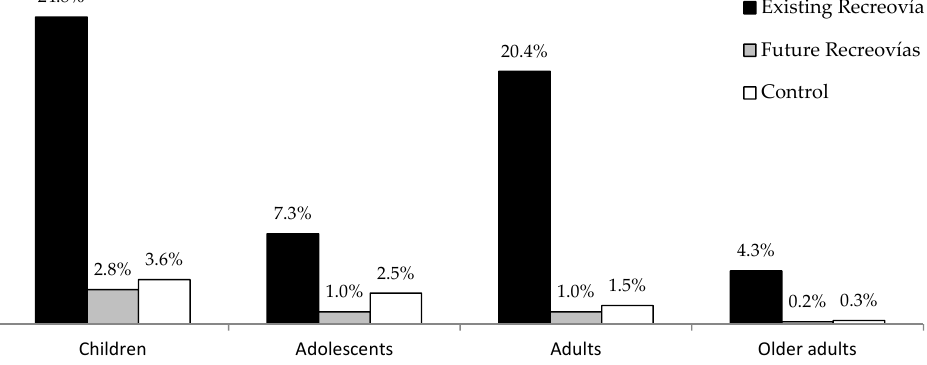
Figure 3. Percentage of park users adjusted by population density, represented by age group and presence of the Recreovía program.